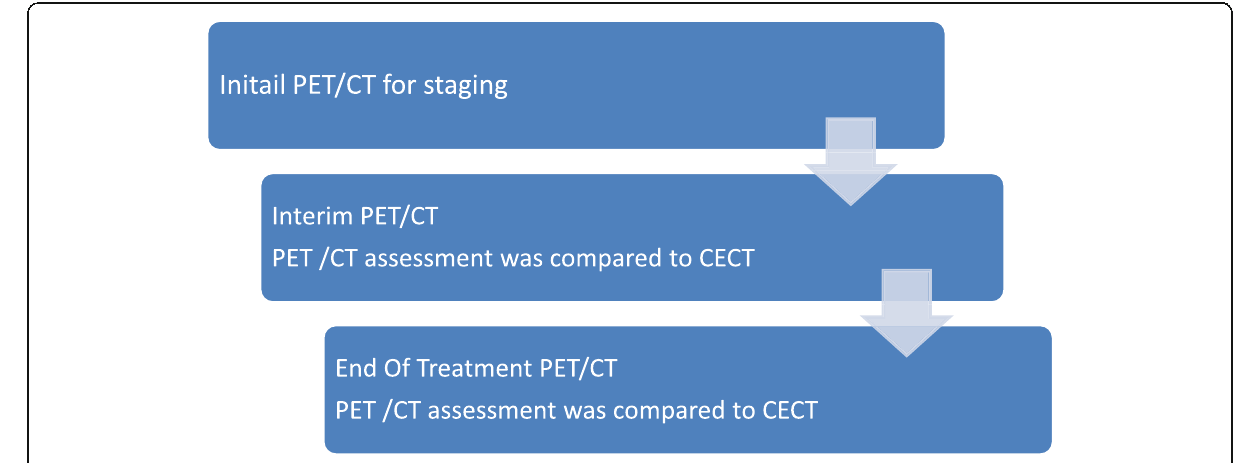
Fig. 1 Flowchart of the research